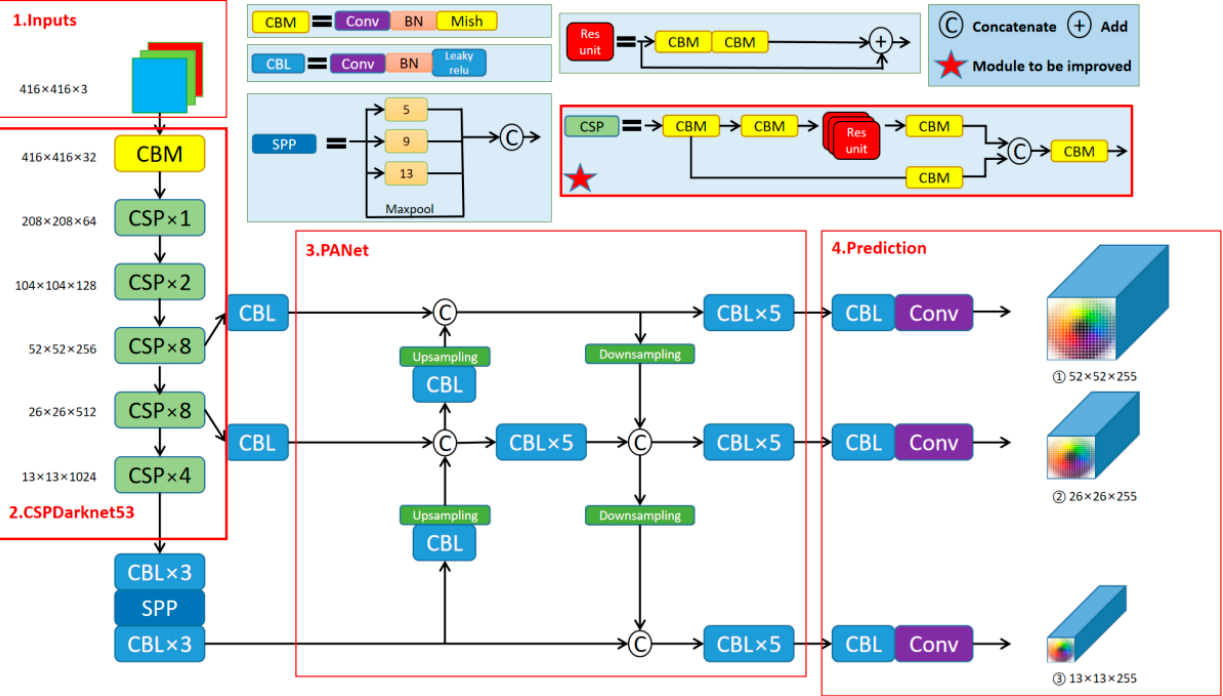
Figure 1. The network structure of YOLOv4.